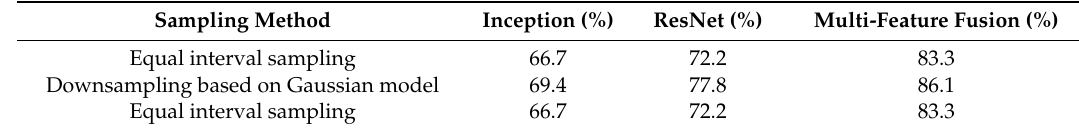
Table 1. Comparison of recognition accuracy of di ff erent sampling